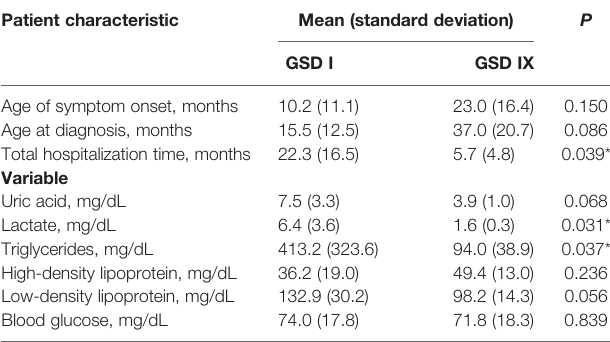
TABLE 2 | Comparison of patients with glycogen storage disease types I and IX. Patient